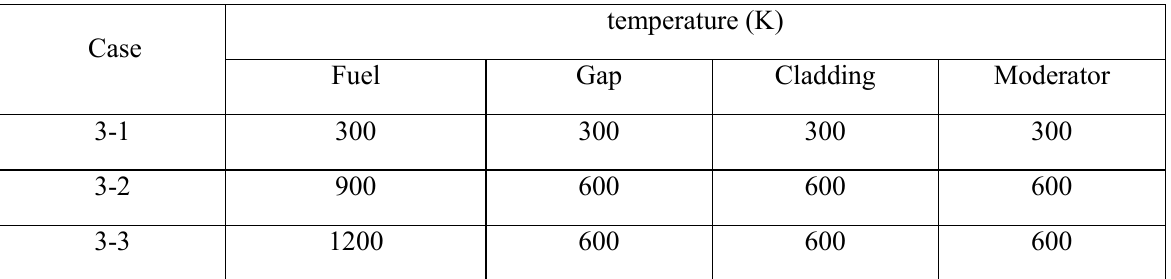
Table VI Comparison of k